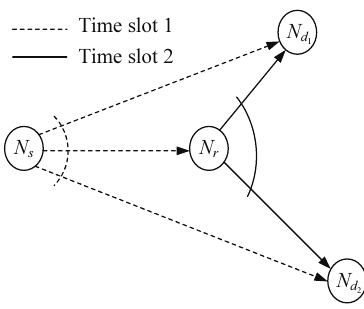
Figure 1. System model of the RBC with two users and one dedicated relay